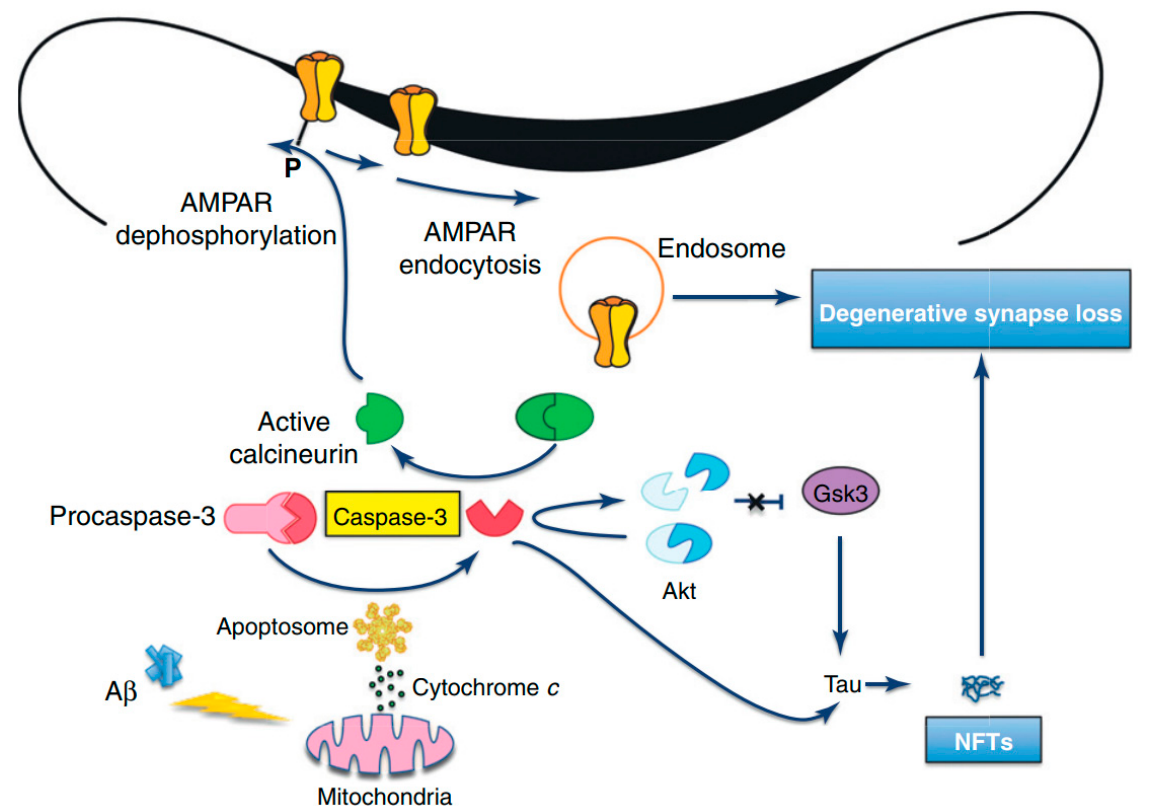
Figure 4. Amyloid beta-induced synapse loss in Alzheimer’s Disease [127]. Abbreviations: Akt, protein kinase B; AMPAR, 2-amino-3-(5-methyl-3-oxo-1,2-oxazol-4-yl)propanoic acid receptor; A β , amyloid beta; GSK3, glycogen synthase kinase-3; NFTs, neurofibrillary tangles. Figure reproduced with permis-sion from Ref [127]. Copyright 2020,